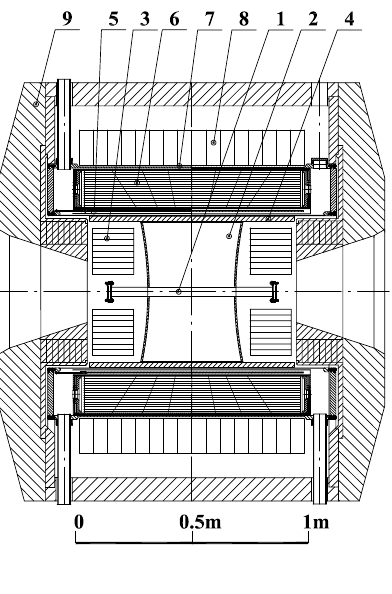
Figure 1. CMD-3 detector: 1 – beam pipe, 2 – drift chamber,